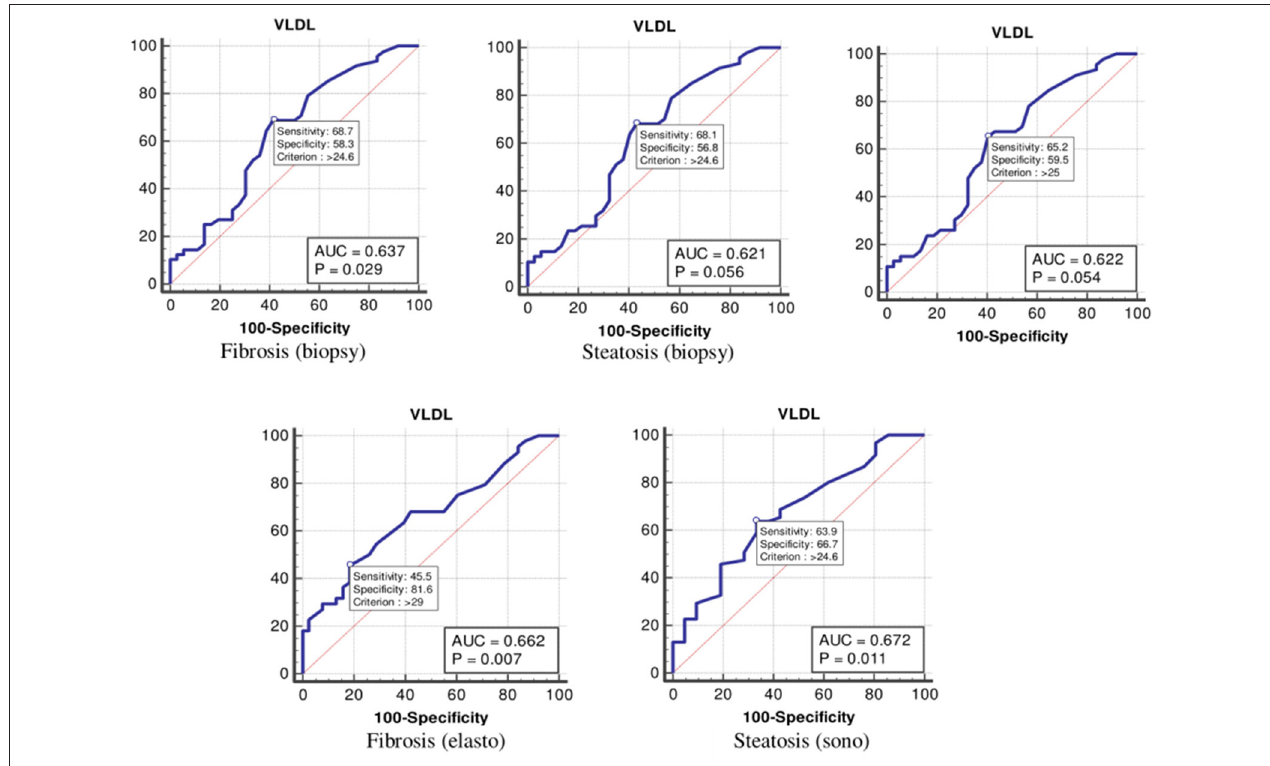
FIGURE 6 | The receiver operating characteristics curve for very low-density lipoprotein in the detection of liver